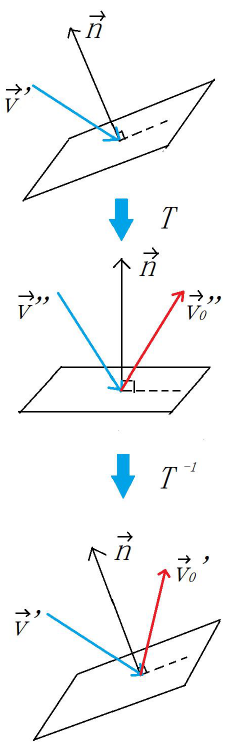
Figure 10. Calculating the direction of rebound.